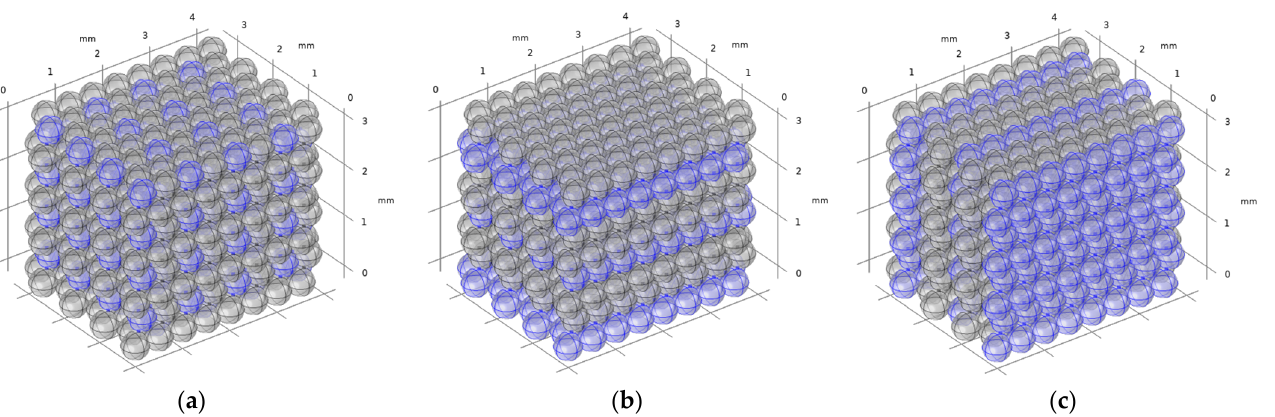
Figure 15. Model to examine the effect of clay content, the blue areas are clay. ( a ) Represents the structural clay; ( b ) represents the laminated clay in the xy plane; ( c ) represents the laminated clay in the xz plane.